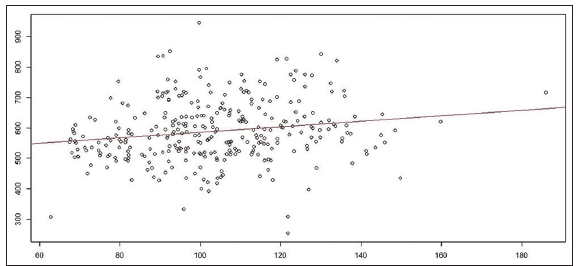
FIGURE 6. Regression line showing the tendency of the linear regression results of the maximum hand grip strength (Y-axis) unit is in Newton and the body weight (X-axis) unit is in kilograms for